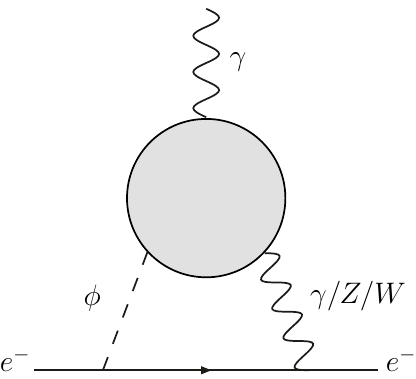
Figure 3 . Two-loop Barr-Zee diagrams contributing to the electron EDM, where φ = h, H, A, H ± . The shaded loop collectively represents the scalar, fermion and gauge boson loops. The total contribution is given by their sum, d e = d φγ